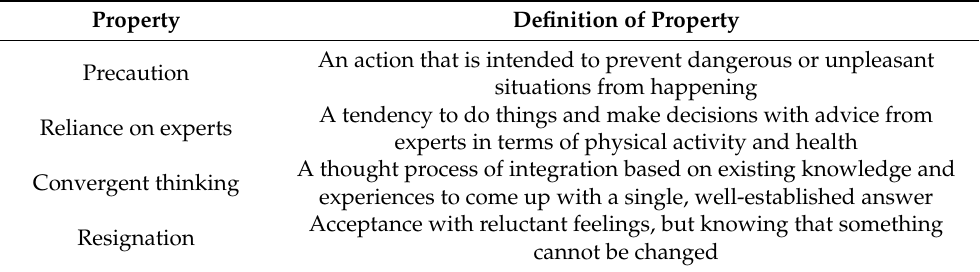
Table 6. Older-old group